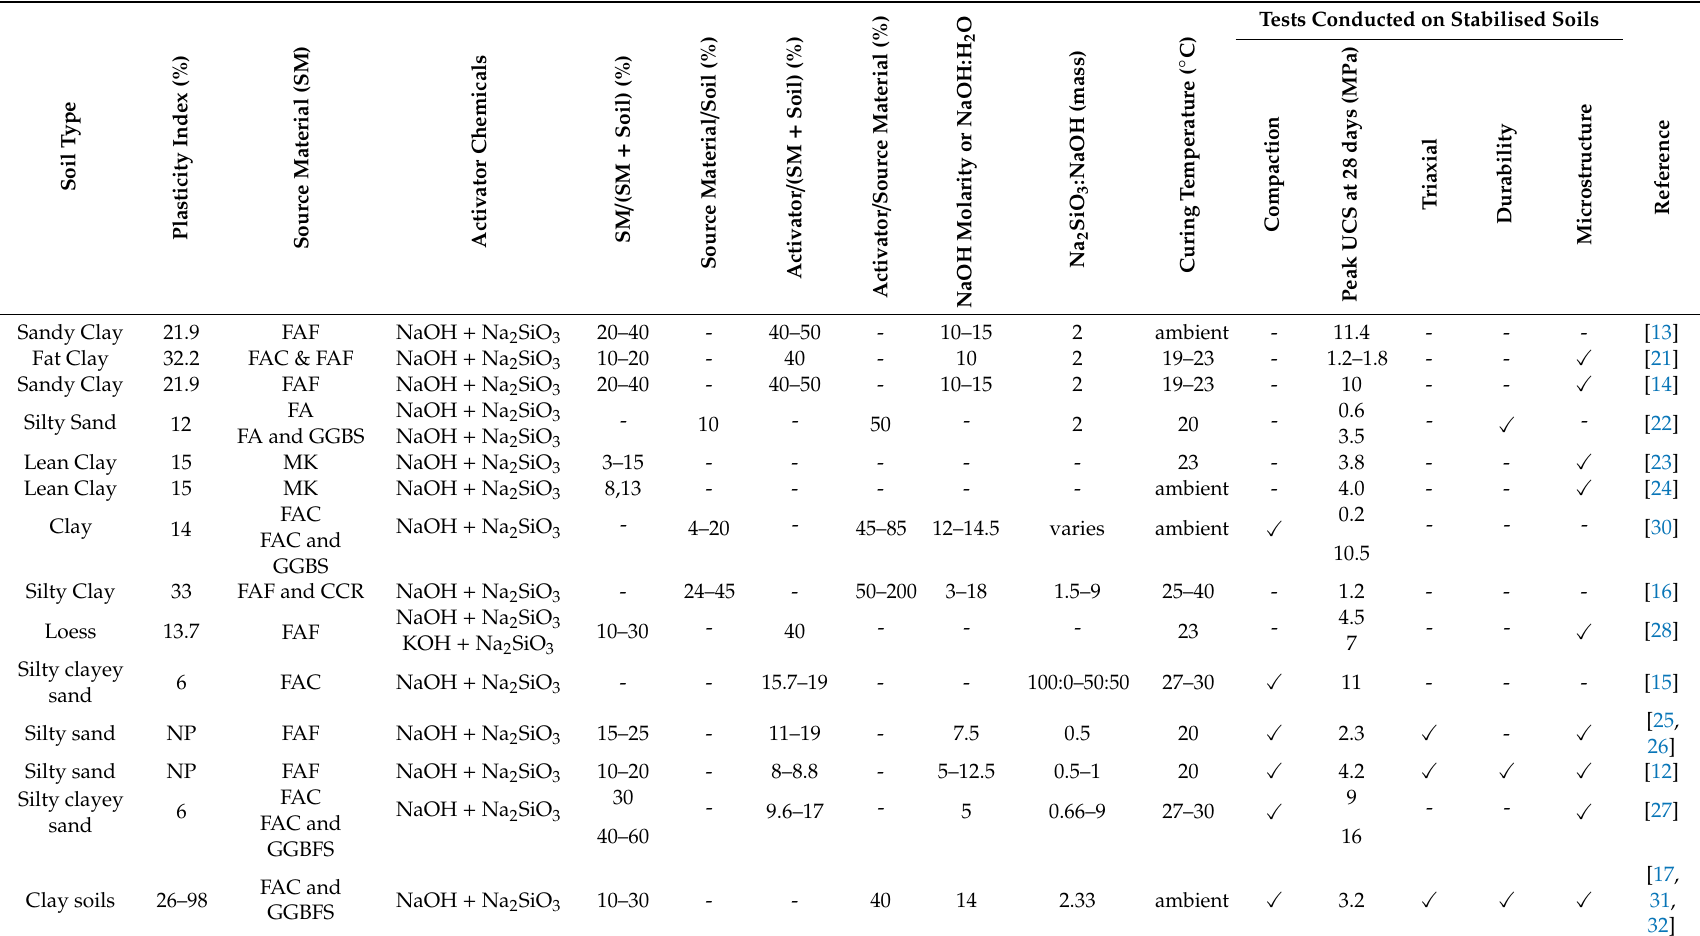
Table 1. Summary of research into the use of geopolymers for soil